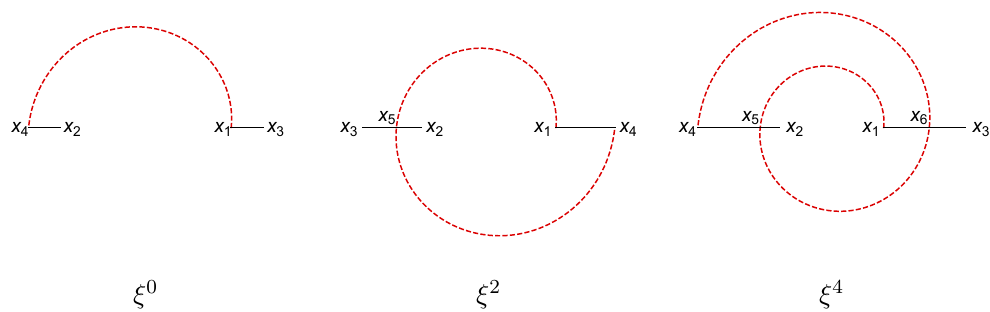
Figure 8 . First 3 orders contributing to the G 1 correlator. We assume that each of x 1 and x 4 points are the sources of two propagators, by that reason x 4 and x 3 are interchanged in the middle picture in comparison to the right and